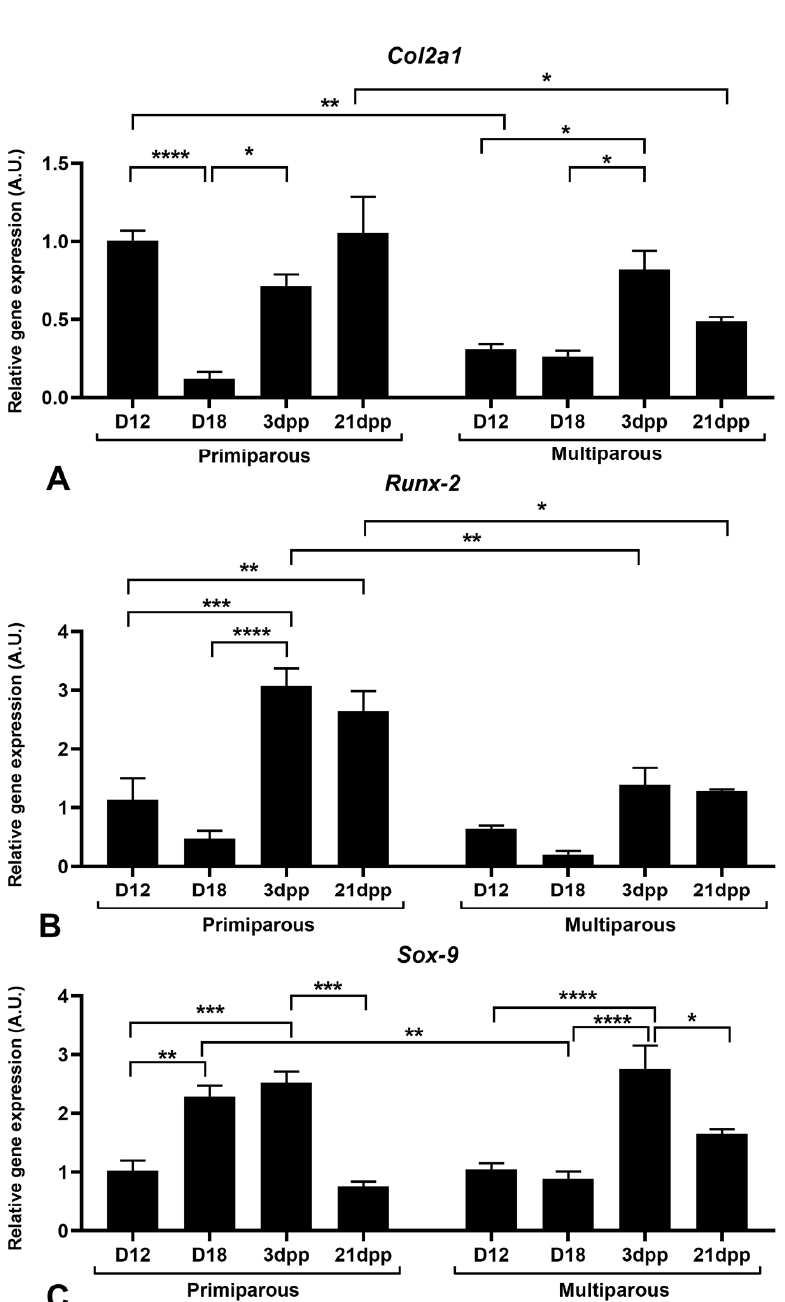
Figure 3. Spatiotemporal gene expression of Col2a1 ( A ), Runx-2 ( B ), and Sox-9 ( C ) at the interpubic joint during pregnancy and postpartum remodeling in primiparous and multiparous senescent female mice by qPCR. Two-way ANOVA with Bonferroni test. Significance p -value < 0.05 (*), < 0.01 (**), < 0.001 (***), < 0.0001 (****). A.U.= arbitrary unit. N = 3 animals per group (D18, and 3dpp); 6 animals per group (D12, and 21dpp).